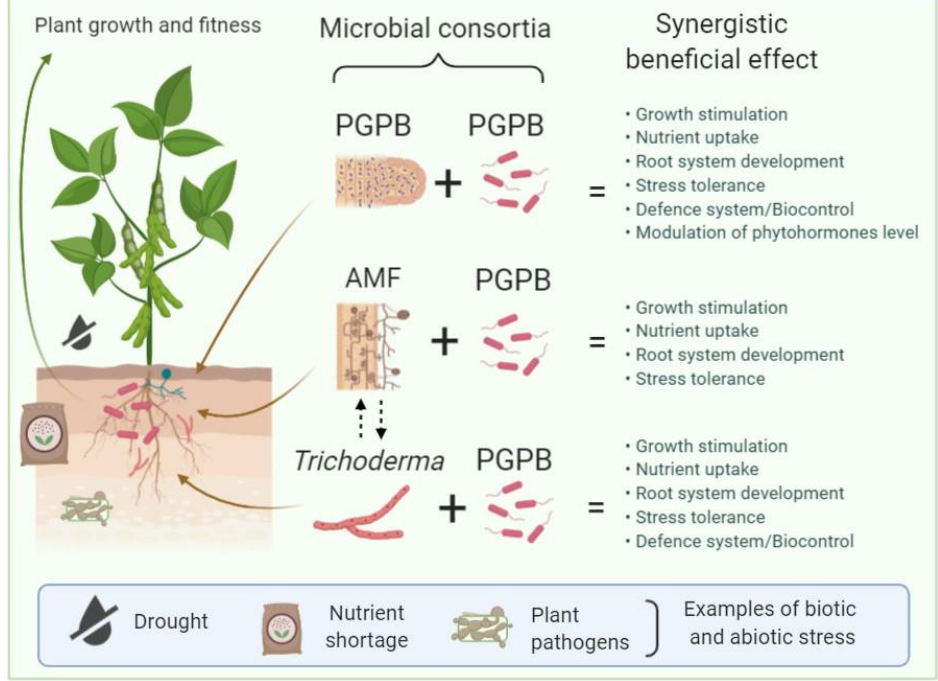
Figure 1. Microbial consortia. Rhizosphere microorganisms like plant-growth-promoting bacteria (PGPB), arbuscular mycorrhizal fungi (AMF), and fungi from the genus Trichoderma spp. can establish beneficial interactions with plants, promoting plant growth and development, increasing the plant defense system against pathogens, promoting nutrient uptake, and enhancing tolerance to different environmental stresses. Rhizosphere microorganisms can influence one another, and the resulting consortia of PGPB + PGPB (e.g., a nitrogen-fixing bacterium such as Rhizobium spp. and Pseudomonas fluorescens), AMF + PGPB, and Trichoderma + PGPB may have synergetic effects on plant growth and fitness, providing the plant with enhanced benefits to overcome biotic and abiotic stress. Dashed arrows indicate beneficial interactions between AMF and Trichoderma .